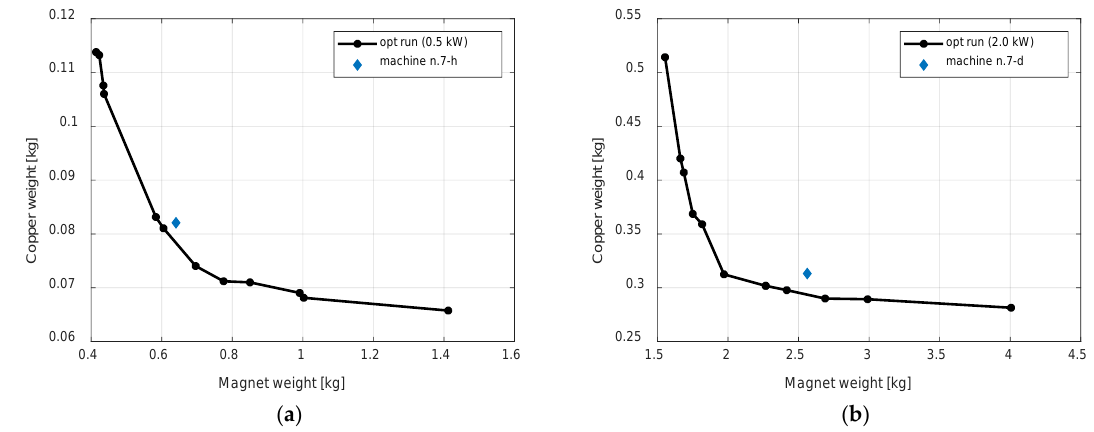
Figure 19. Comparison between optimally designed machines and scaled machines with half-power ( a ) and double-power ( b ) with respect to the base machine.